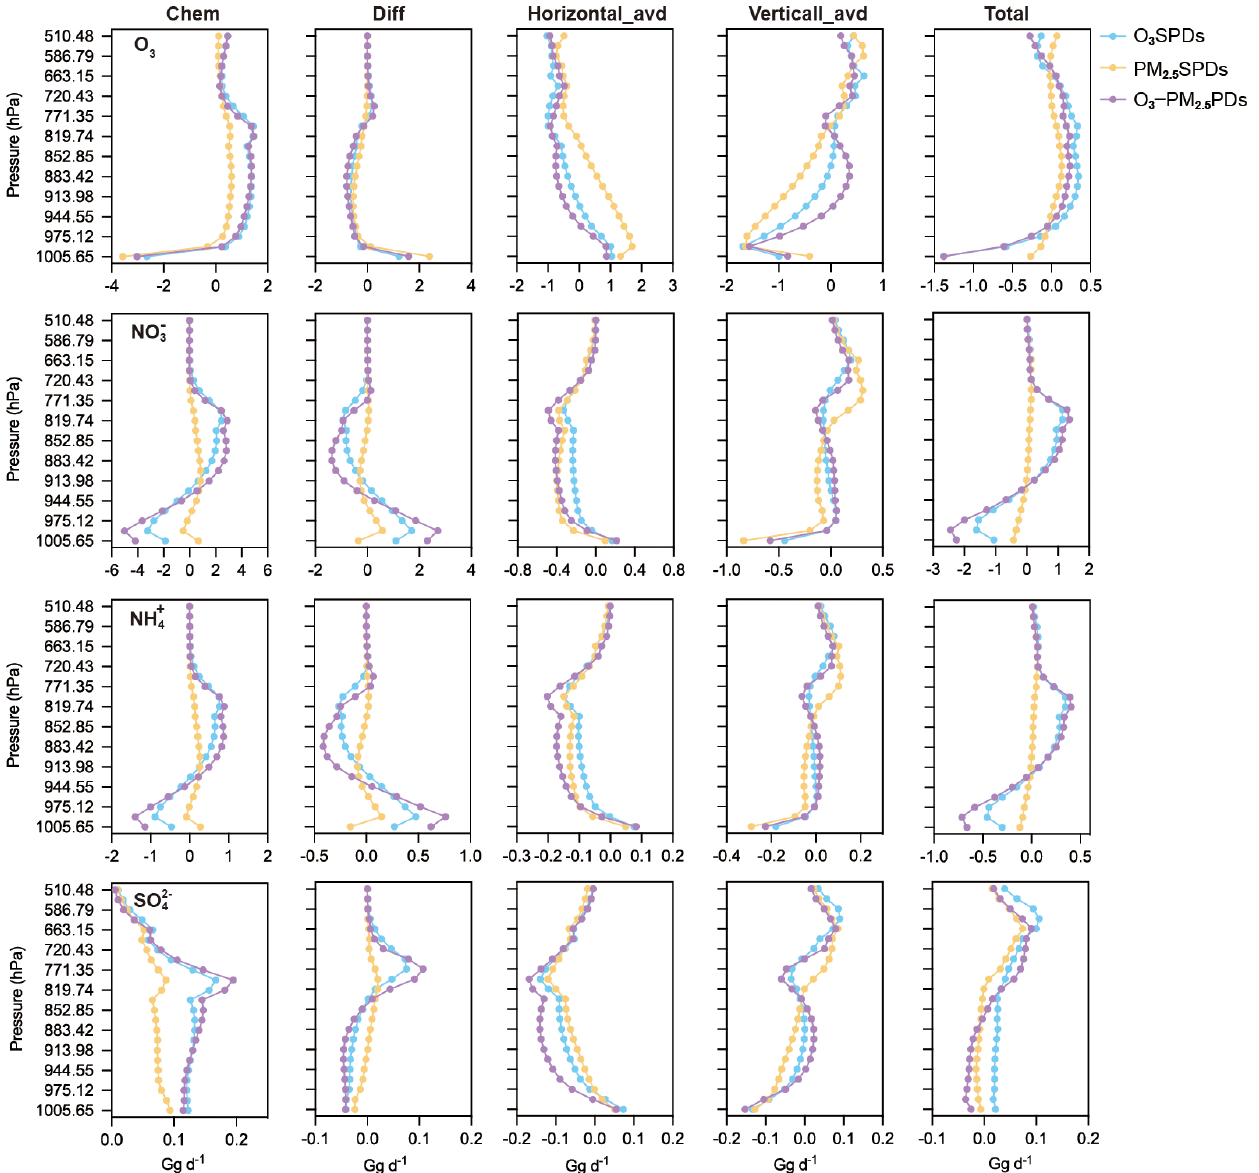
− , NH + , and SO 2 − (Ggd − 1 ) over BTH by each process and the total processes. 3 4 4